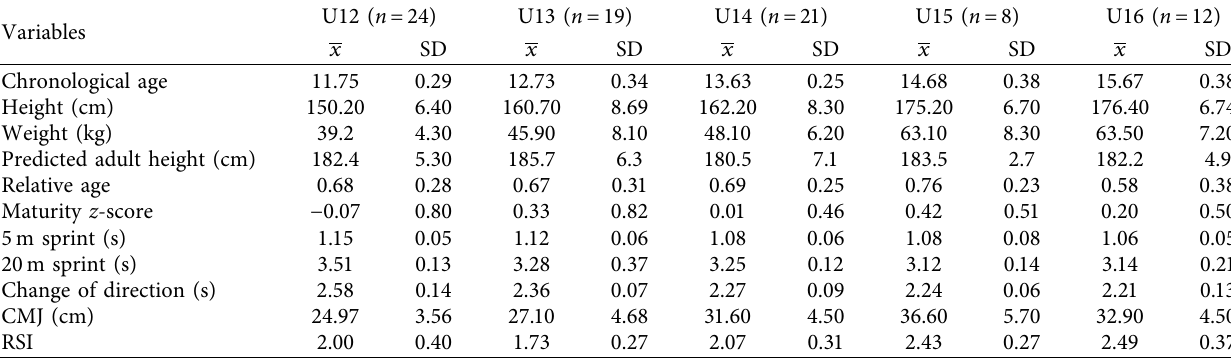
Table 1: Descriptive statistics of participants per age